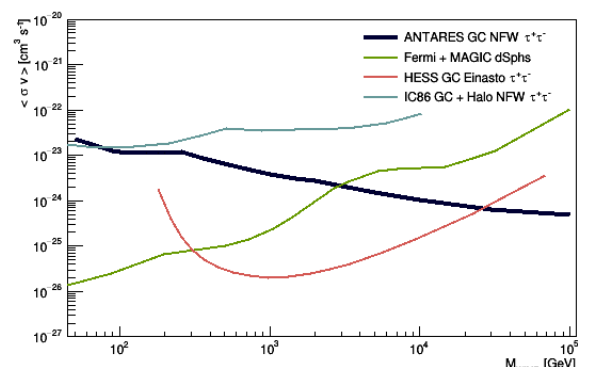
Figure 5 . ANTARES limits on the thermally averaged annihilation cross-section as a function of the dark matter particle mass. Results of other experiments are also shown for